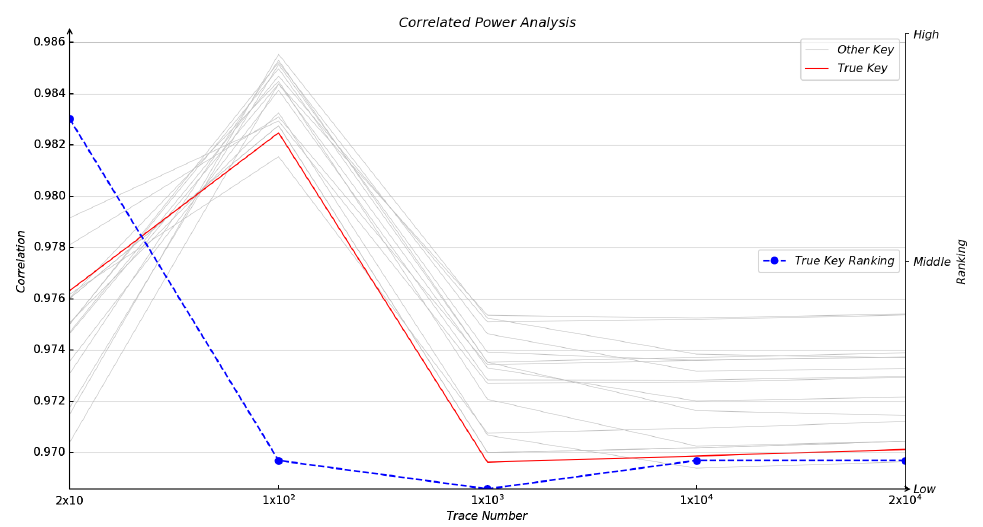
Figure 17. CPA attack on the fourth round of PRINCE using the method in